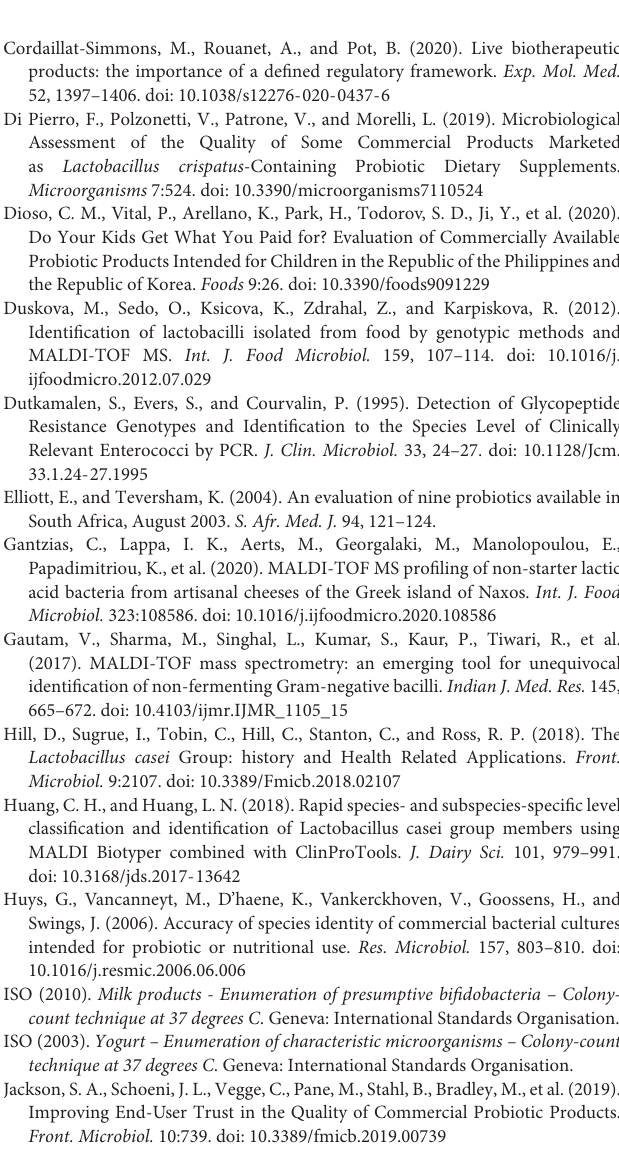
species-specific PCR (three isolates per labelled